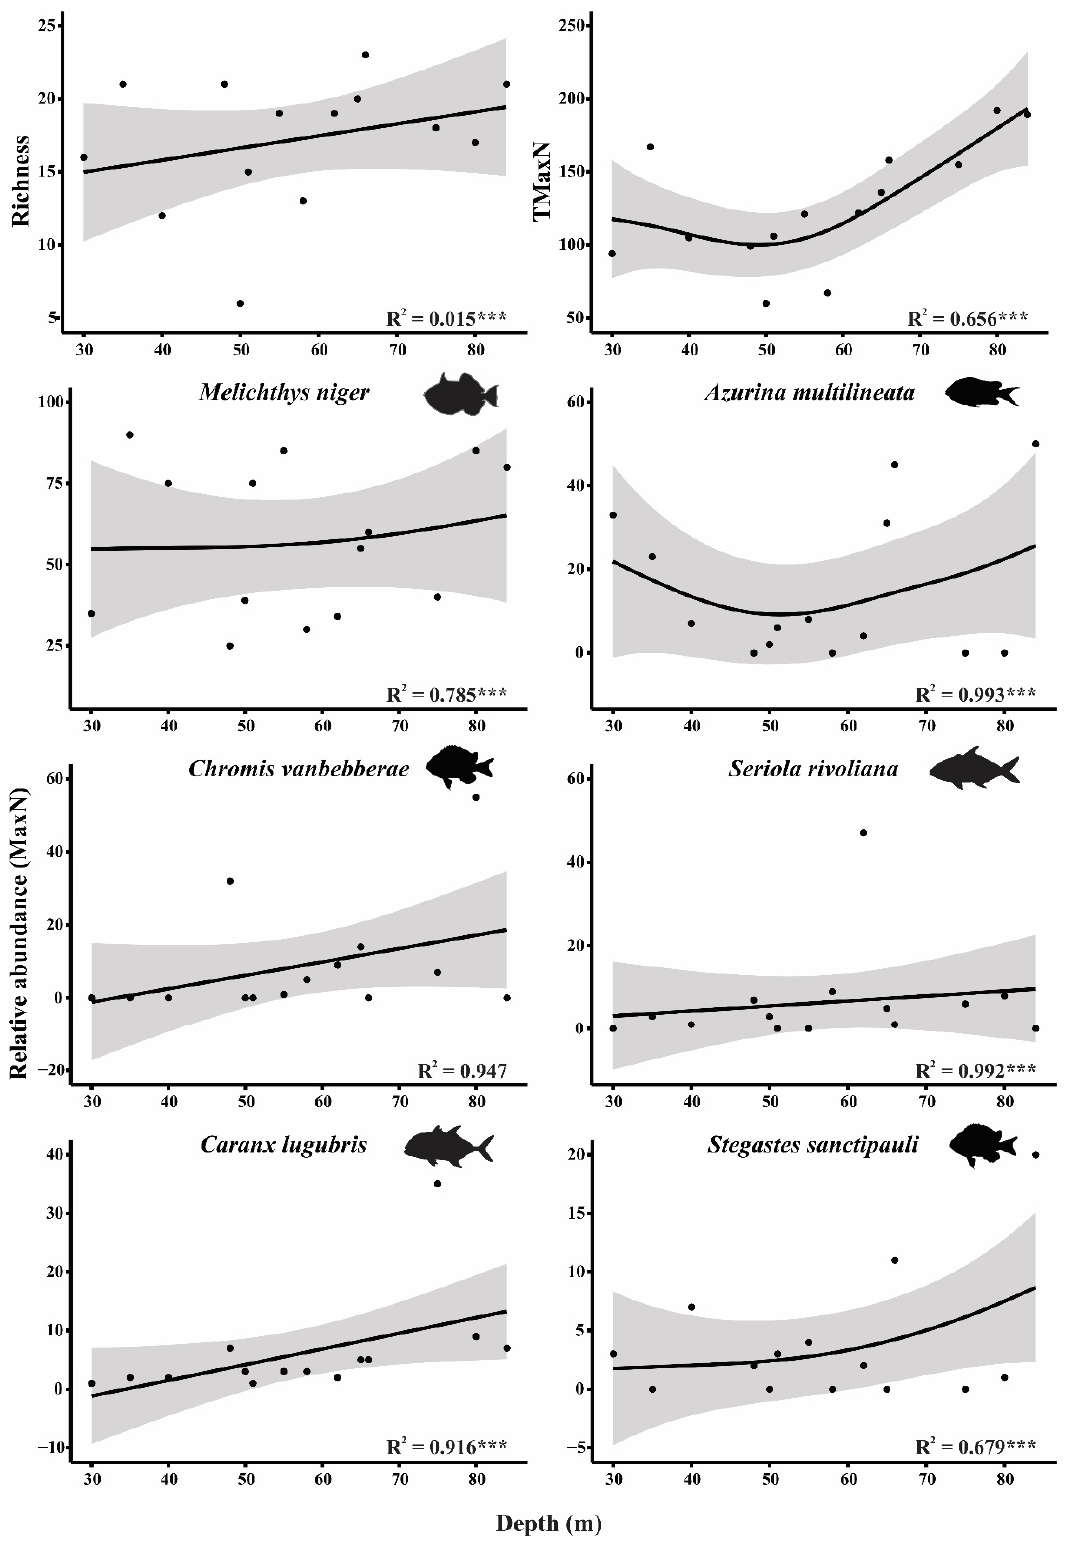
Figure 4. Relationship between species richness, total relative abundance (TMaxN) and relative abundance (MaxN) of the six most abundant species and depth according to the generalized additive models. Each dot represents a BRUVS deployment. 95% confidence limits are shown in gray. *** p < 0.001.